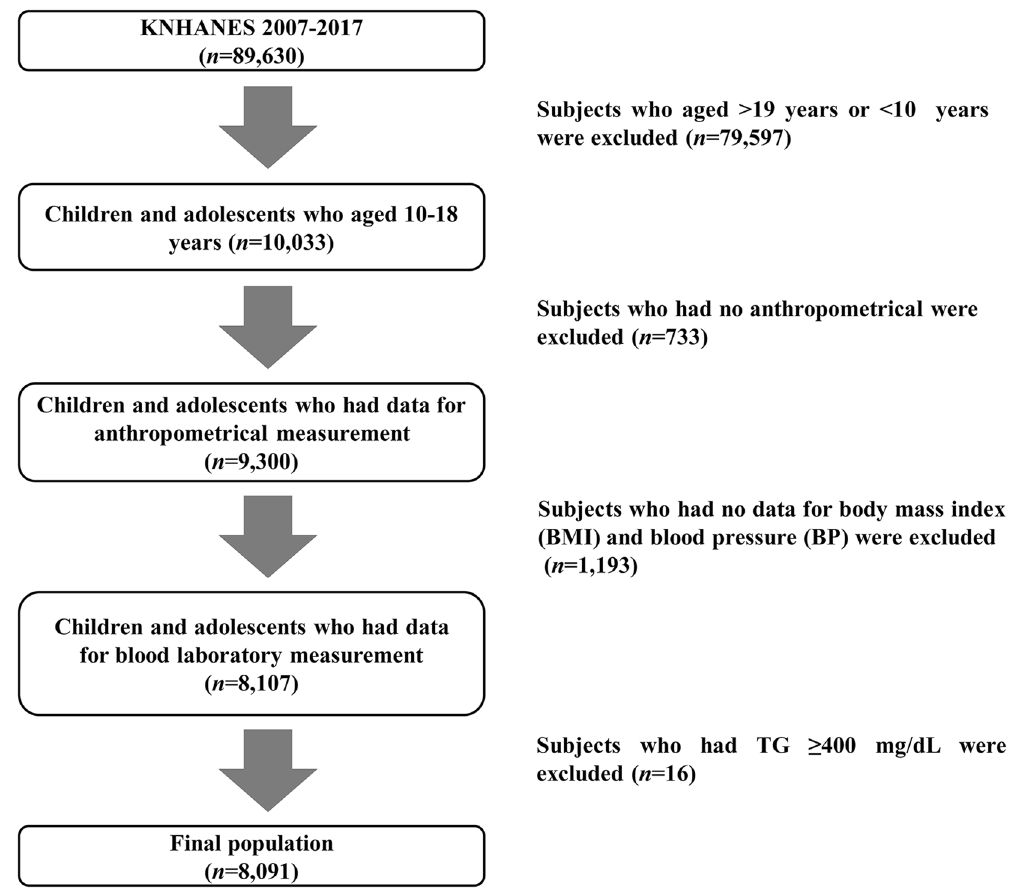
Figure 2. Flow chart of the study